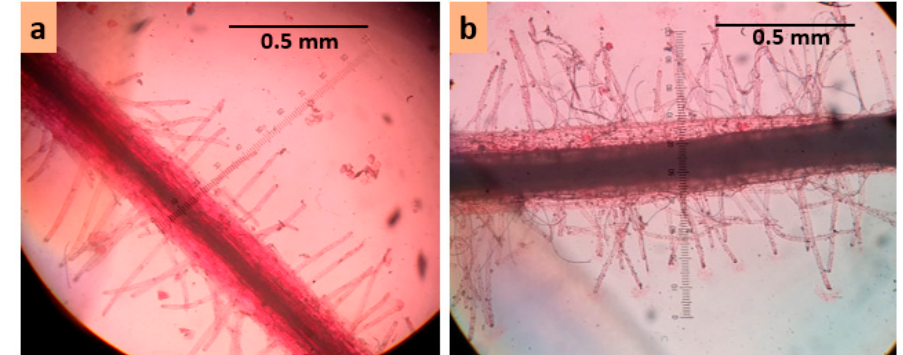
Figure 3. Measurement of root hair traits under microscope ( a ) first-order lateral root of Binasarisha-5 in control conditions, and ( b ) first-order lateral root of BARI sarisha-8 in 100 mM NaCl treated conditions.